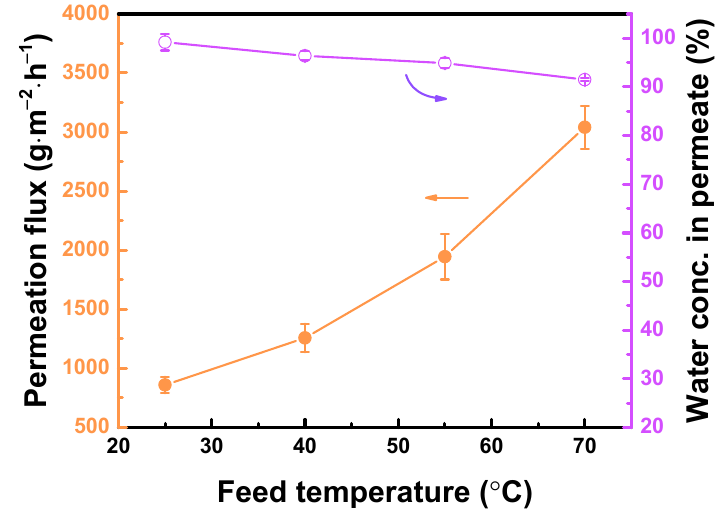
Figure 8. TFC isopentane membrane performance at different operating feed temperature. Feed = 90 wt% aqueous ethanol solution. Downstream pressure = 13 mmHg.